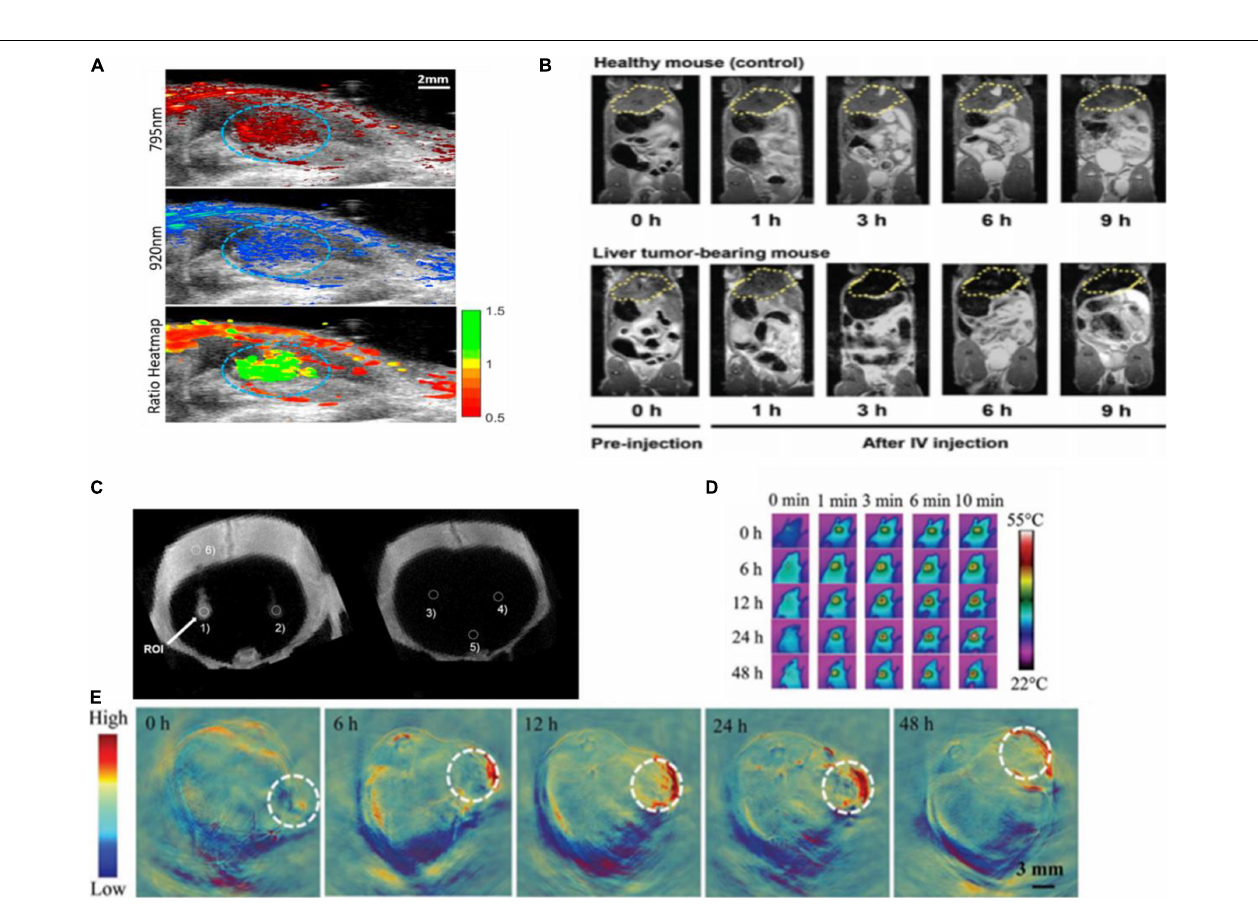
FIGURE 9 | (A) The US/PA image of labeled stem cells (circled in blue) in vivo . Reprinted with permission from Dhada et al. (2019), Copyright (2019), American Chemical Society. (B) MRI imaging using SPAuNC (aff+) as a contrast agent from the mice bearing a liver tumor and healthy mice; the tumor-grafted liver was clearly differentiated from the normal liver of healthy mice. Reprinted with permission from Kwon et al. (2017), Copyright (2017), John Wiley and Sons. (C) In vivo micro-CT images of AuNP-PLL-RITC-labeled hMSCs. Reprinted with permission from Kim et al. (2017), Copyright (2017) John Wiley and Sons. (D) Photothermal and (E) photoacoustic imaging of Capan-1 tumor-bearing nude mice injected with rGADA. Reprinted (adapted) with permission from Jia X. et al. (2020), Copyright (2020) John Wiley and Sons.